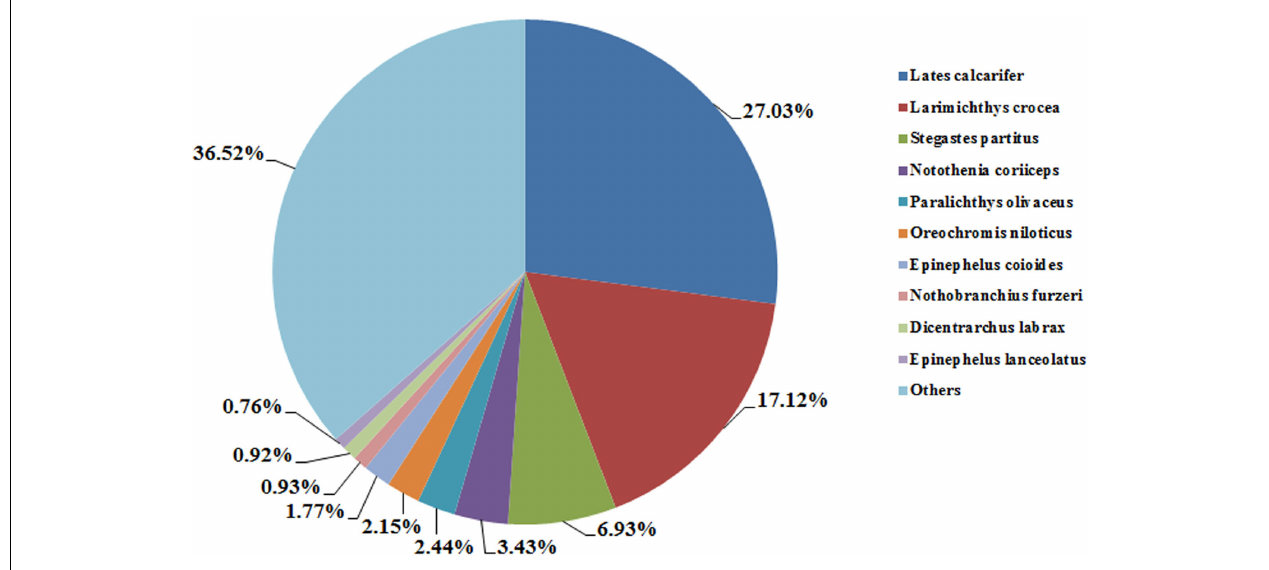
FIGURE 4 | Species distribution of the Nr annotation of the long-read